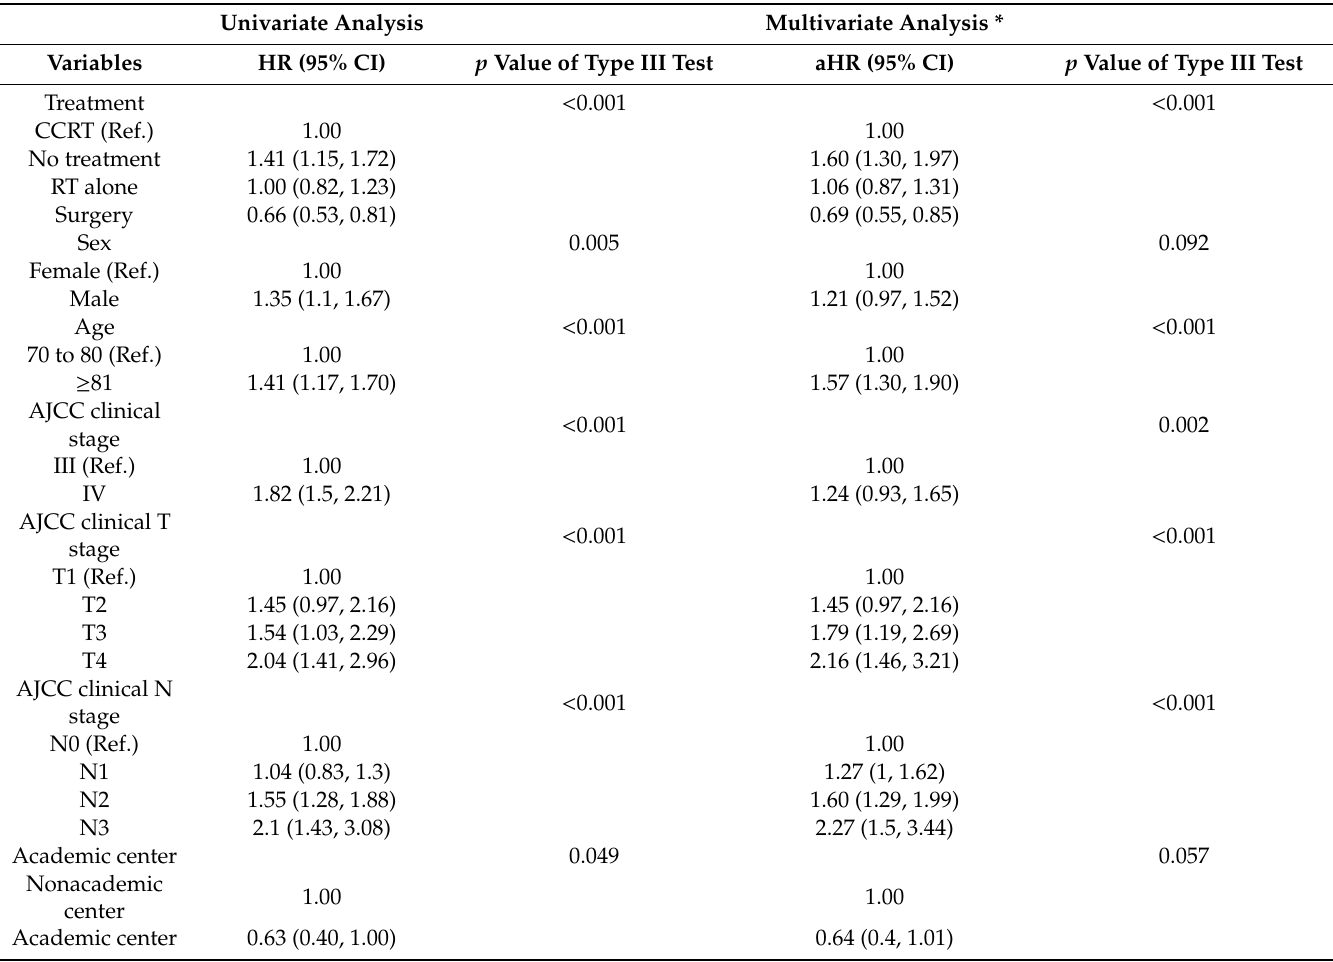
Table 2. Cox Proportional Hazards Regression Analysis of Death Risk among Elderly Patients (aged ≥ 70 years) with Locally Advanced Oral Cavity Squamous Cell